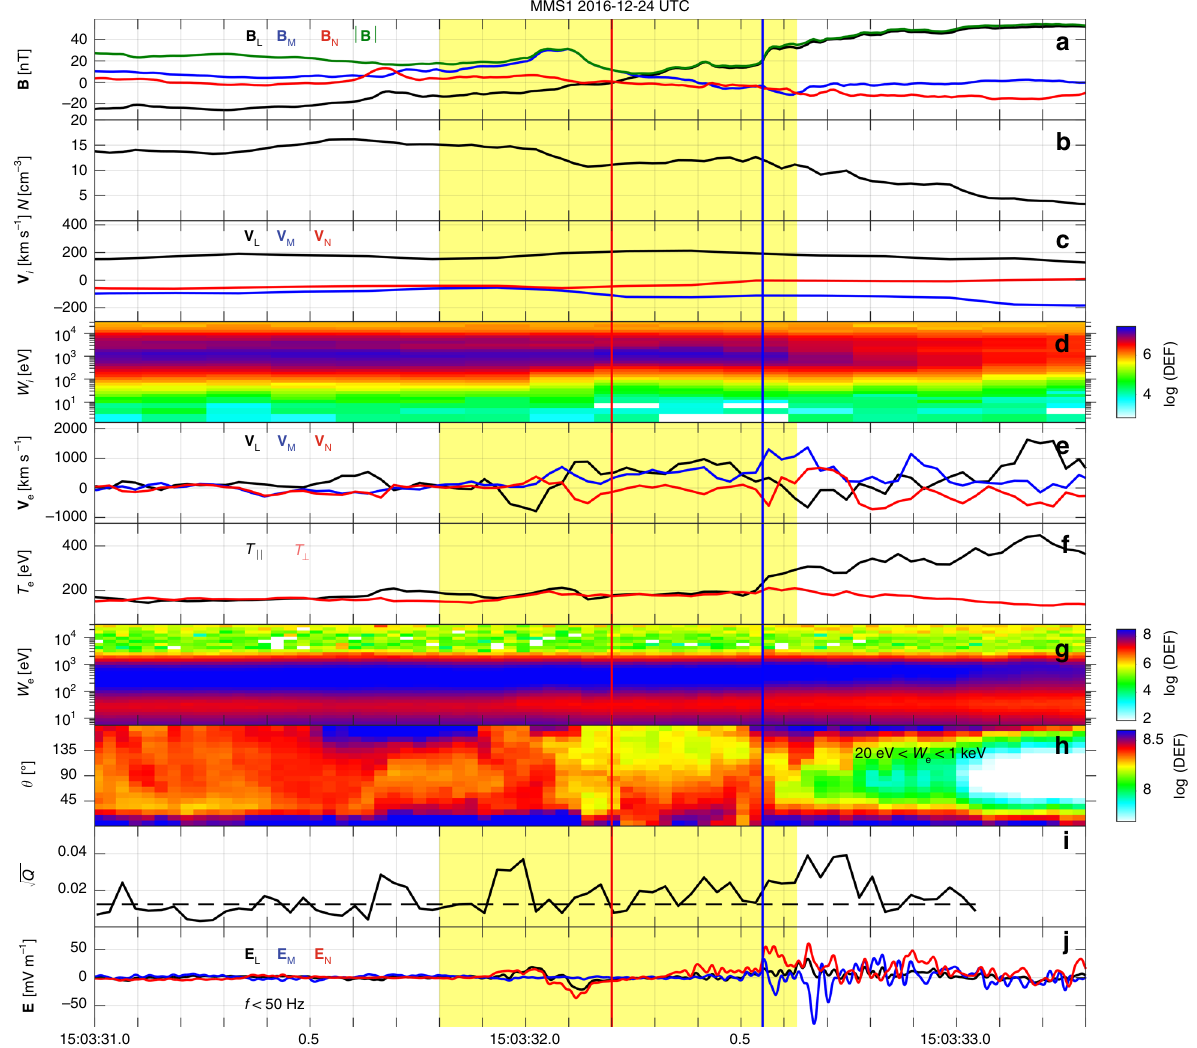
. d Ion differential energy fl ux (color scale, in unit of keV s (cid:1) 1 cm (cid:1) 2 sr (cid:1) 1 i